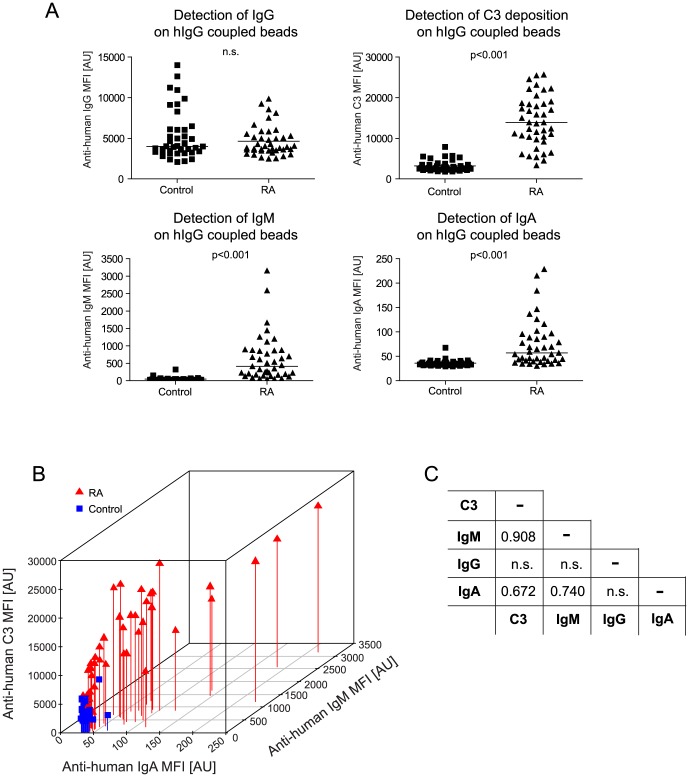
Complement activation by rheumatoid factors.Following incubation of human-IgG coupled beads in sera of RA patients or non-diseased controls, bound IgG-specific rheumatoid factors and deposited C3 fragments were detected. A
) Median fluorescence intensities (MFI) for anti-IgG, anti-IgM, anti-IgA and anti-C3 secondary antibodies are plotted separately for the RA patients and controls. Statistical differences between these two groups were calculated by Mann-Whitney non-parametric test. B
) Anti-IgA, anti-IgM and anti-C3 MFI values for the human-IgG coupled bead within RA patient group (Δ) and controls (▪) are plotted in a 3D graph for visualization of their correlation to each other. Anti-IgG MFI values are excluded from this plot since they not reveal a significant difference between the two groups. C) The table shows the Spearman's Rho correlation coefficients between anti-C3, anti-IgG, anti-IgM and anti-IgA MFI values in the entire sample cohort, where only statistically significant (p-value < 0.05) correlation coefficients are shown and non-significant correlations are indicated by (n.s.).